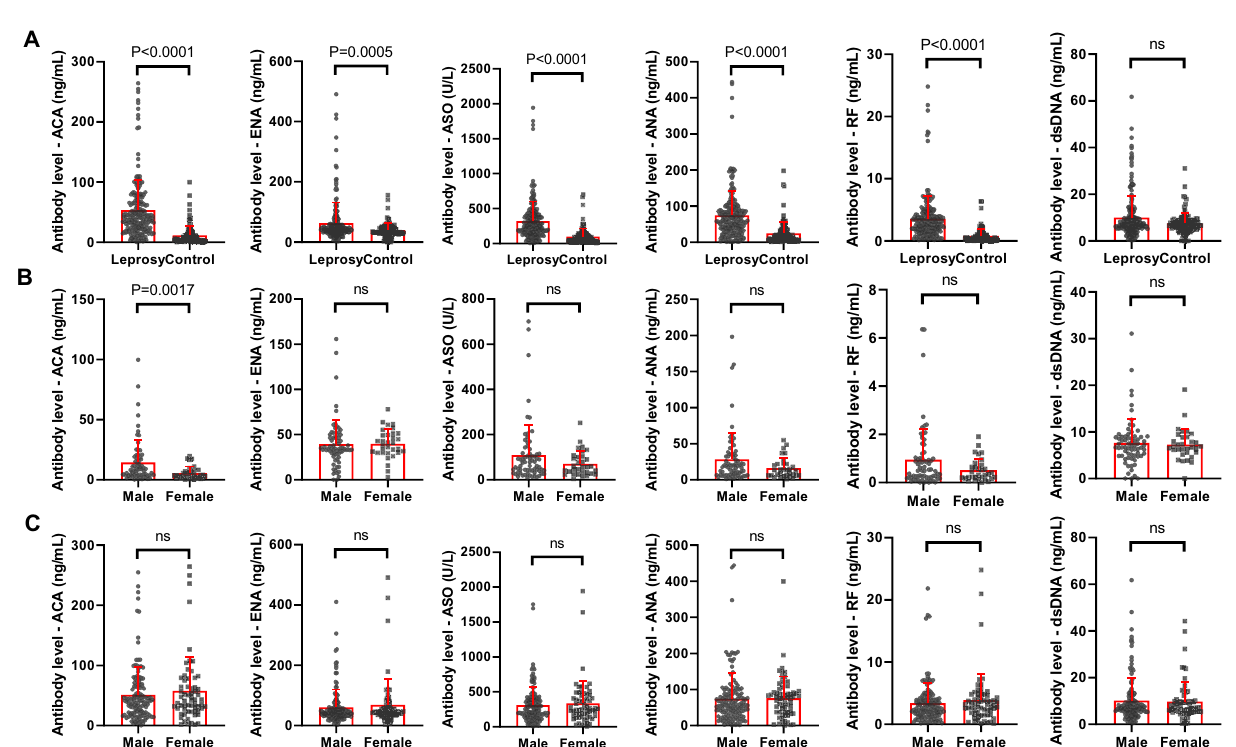
Figure 1. Circulating levels of autoantibodies in cured leprosy patients and controls. ( A ) Comparison of the levels of the autoantibodies in plasma of cured leprosy patients with those of healthy controls. ( B ) Sex-specific level of the autoantibodies in plasma of controls. ( C ) Sex-specific level of the autoantibodies in plasma of cured patients. ACA, anticardiolipin IgG antibody; ENA, anti-extractable nuclear antigen antibody; ASO, human anti-streptolysin O; ANA, antinuclear antibody; RF, human rheumatism factor; dsDNA, anti-double-stranded DNA antibody. Comparisons of the level of each autoantibody in two groups were conducted using the non- parametric Mann–Whitney test. ns: not